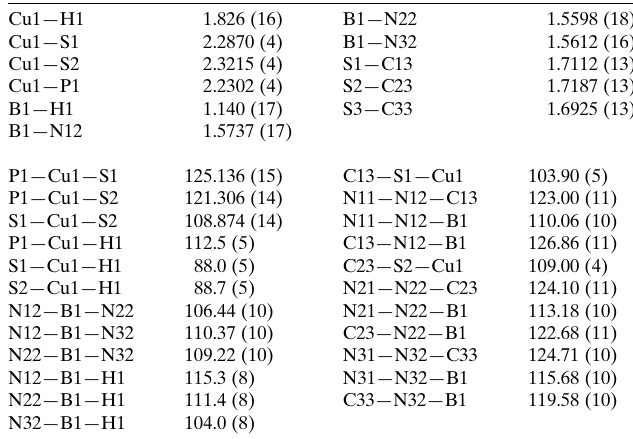
Table 1 Selected geometric parameters (A˚ , (cid:4) ).